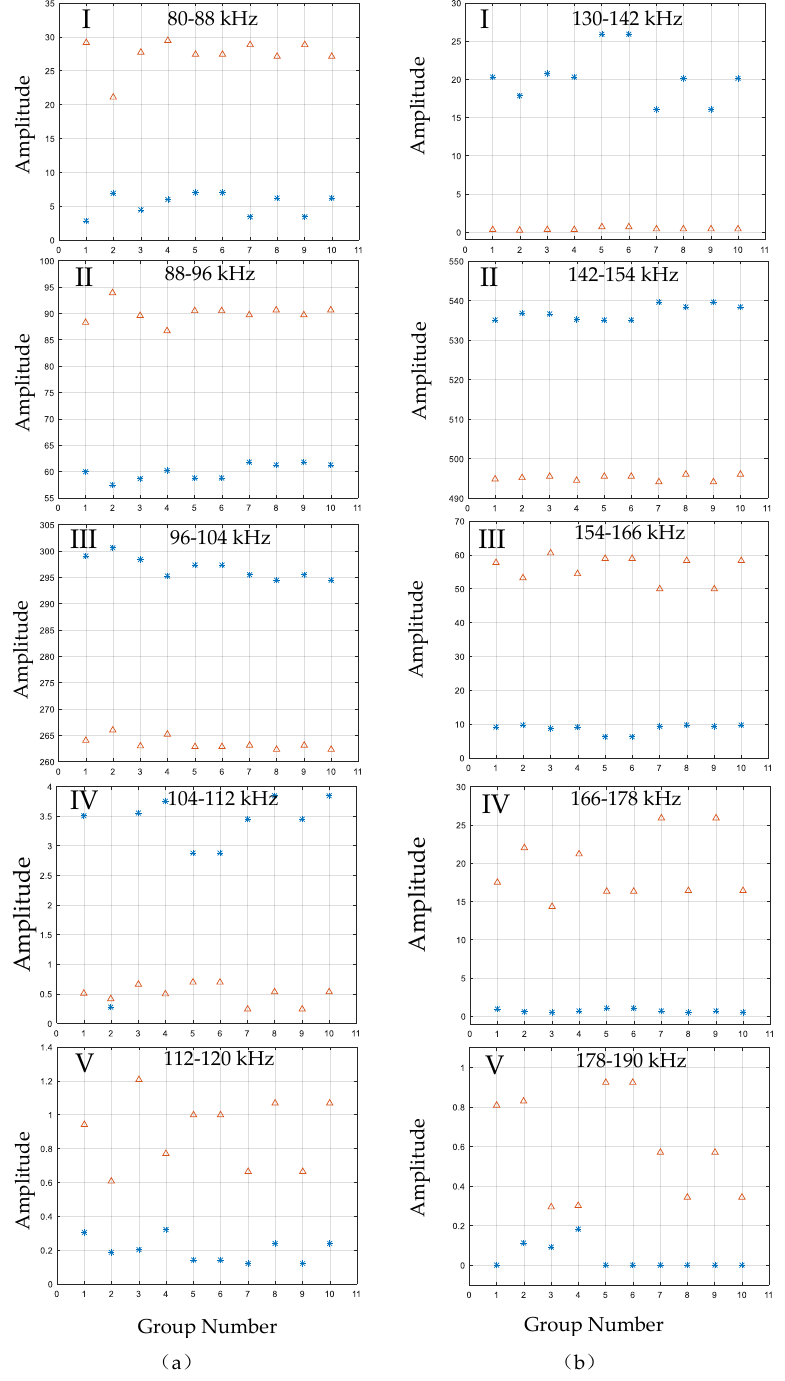
Figure 7. The frequency range around the two excitation frequencies is divided into five frequency bands and the marginal spectrum amplitude of the Lamb wave in each frequency band. “*” is the marginal spectrum amplitude before the plate damage, and “ ∆ ” is the marginal spectrum amplitude after the plate damage. Subfigures ( I – V ) relate to the five frequency bands. ( a ) The marginal spectrum of 100 kHz excited Lamb waves; ( b ) The marginal spectrum of 150 kHz excited Lamb